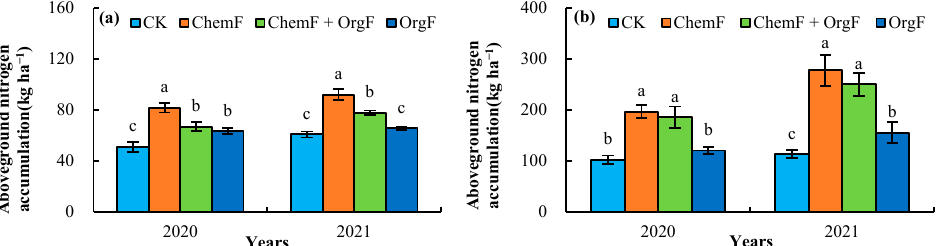
Figure 2. Aboveground nitrogen accumulation under four treatments in soybean ( a ) and maize ( b )